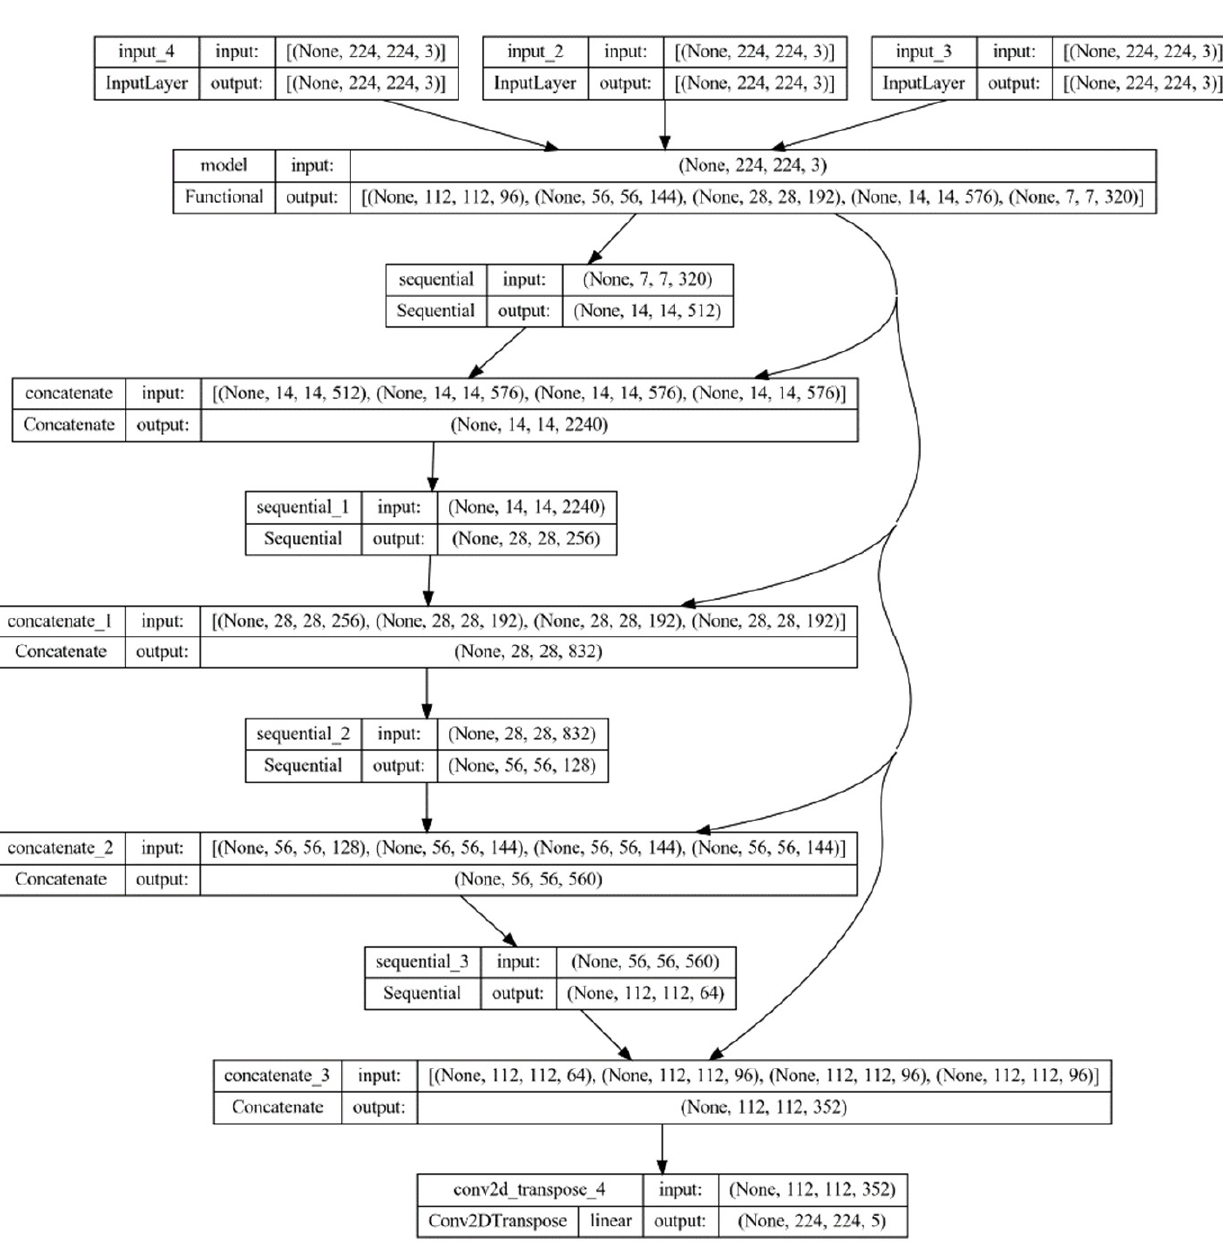
Figure A2. Segmentation model architecture with two data sources as input.